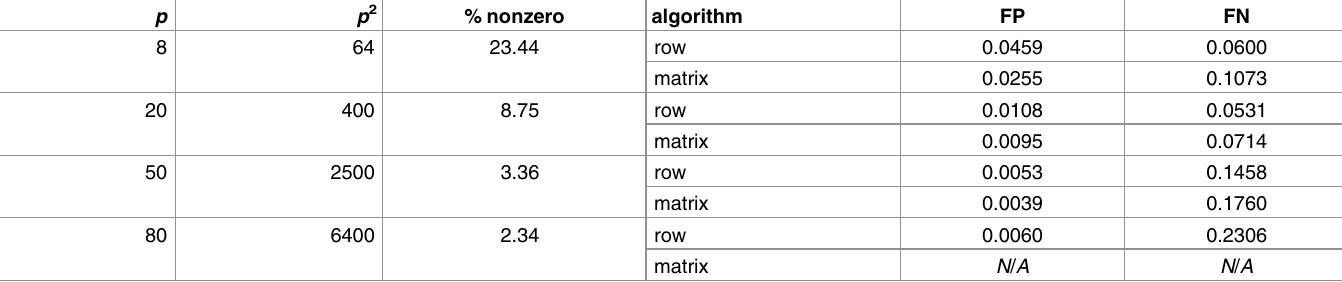
Table 1. Simulation results: Comparisons of variable selection performance between the row-based and matrix-based ERM algorithms. p p 2